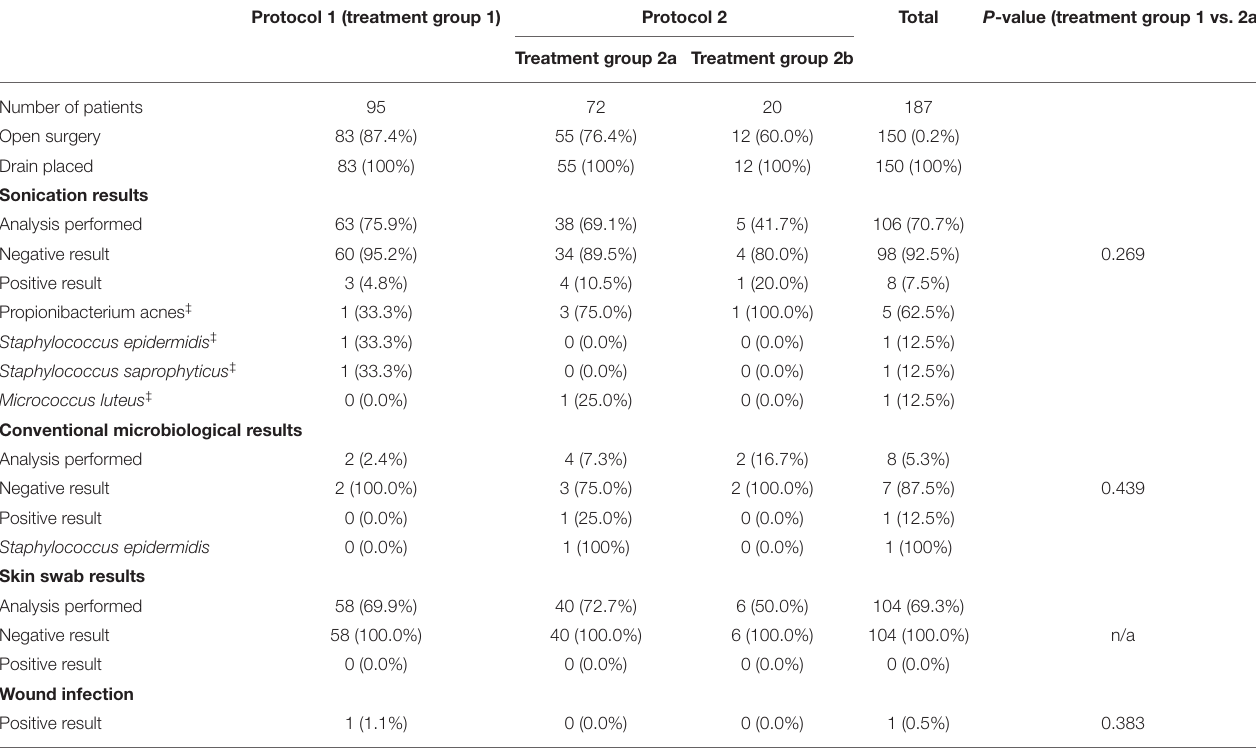
TABLE 2 | Baseline infection characteristics of all included